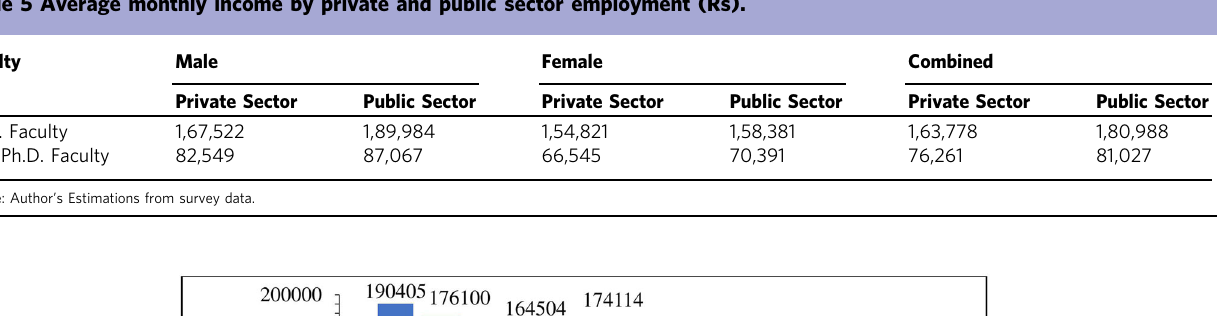
Fig. 5 Average monthly income by designation (PKR). It shows the average monthly income of Professors, Associate Professors, Assistant Professors, and lecturers compared to managers and research associates. Table 5 Average monthly income by private and public sector employment